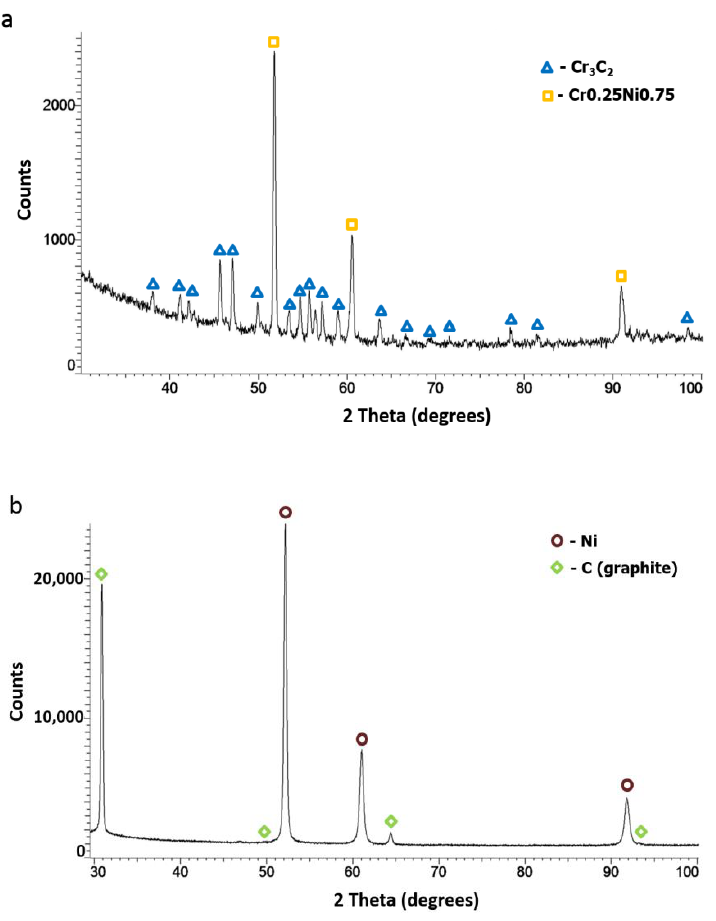
Figure 4. XRD patterns of powders: ( a ) Cr 3 C 2 -25(Ni20Cr), ( b ) Ni-25Graphite.